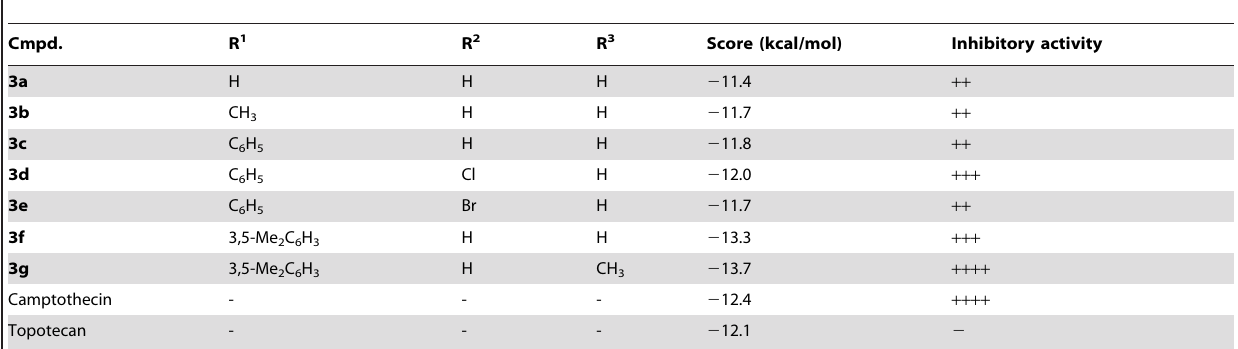
Table 2. Quantification of the affinities of compounds 3a – g for their binding sites and its correlation with their inhibitory activity.